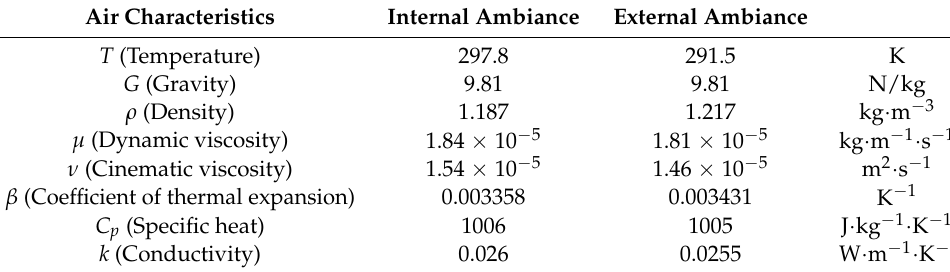
Table 5. Air characteristics depending on